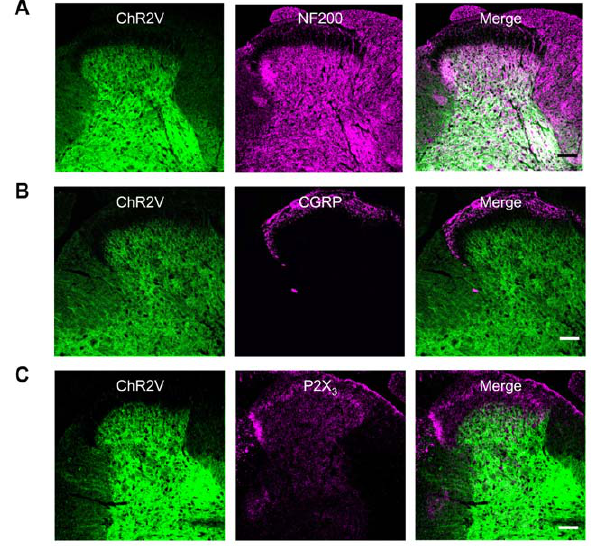
Figure 3. Distribution of ChR2V in the dorsal part of the spinal cord. A–C. Immunohistochemical localization of ChR2V with the cell- type specific markers, NF200 (A), CGRP (B) or P2X 3 (C). Scale bars indicate 40 m m.